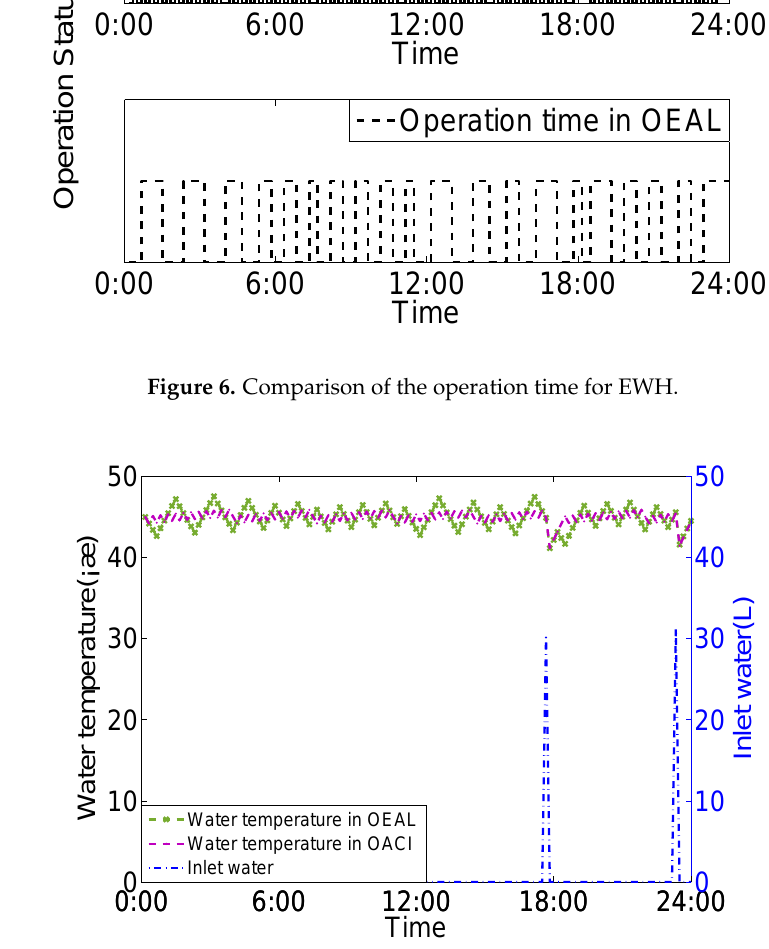
Figure 7. Comparison of the water temperature for